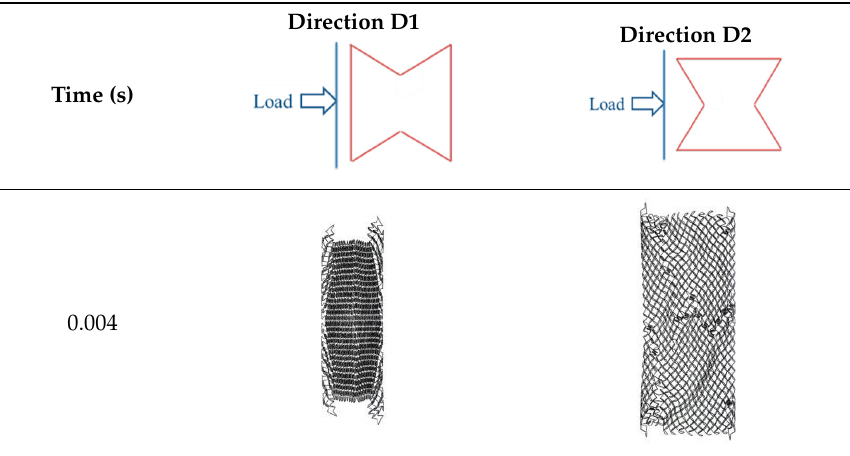
Figure 5. Ratio of compressed length to total length per time, for an auxetic core loaded in two different directions D1 and D2 ( t = 0.75 mm, L = 5 mm, t/L = 0.15, 𝜃 = 60°, AL2 grade).